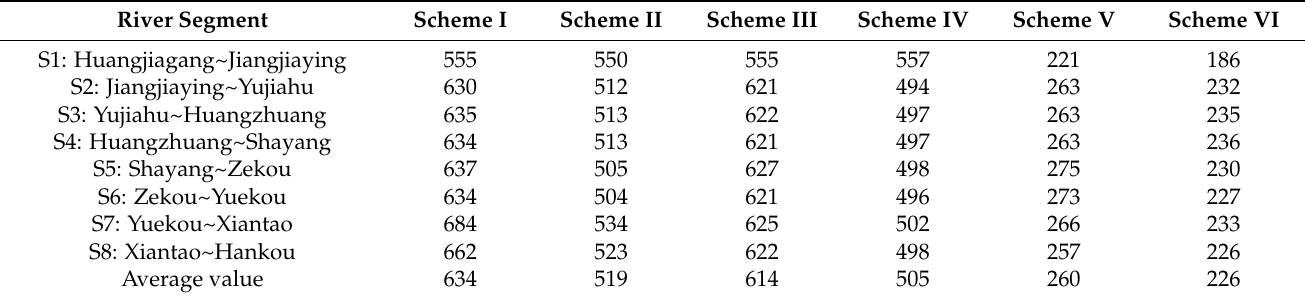
Table 7. The designed low water flows in eight river segments (m 3 /s).